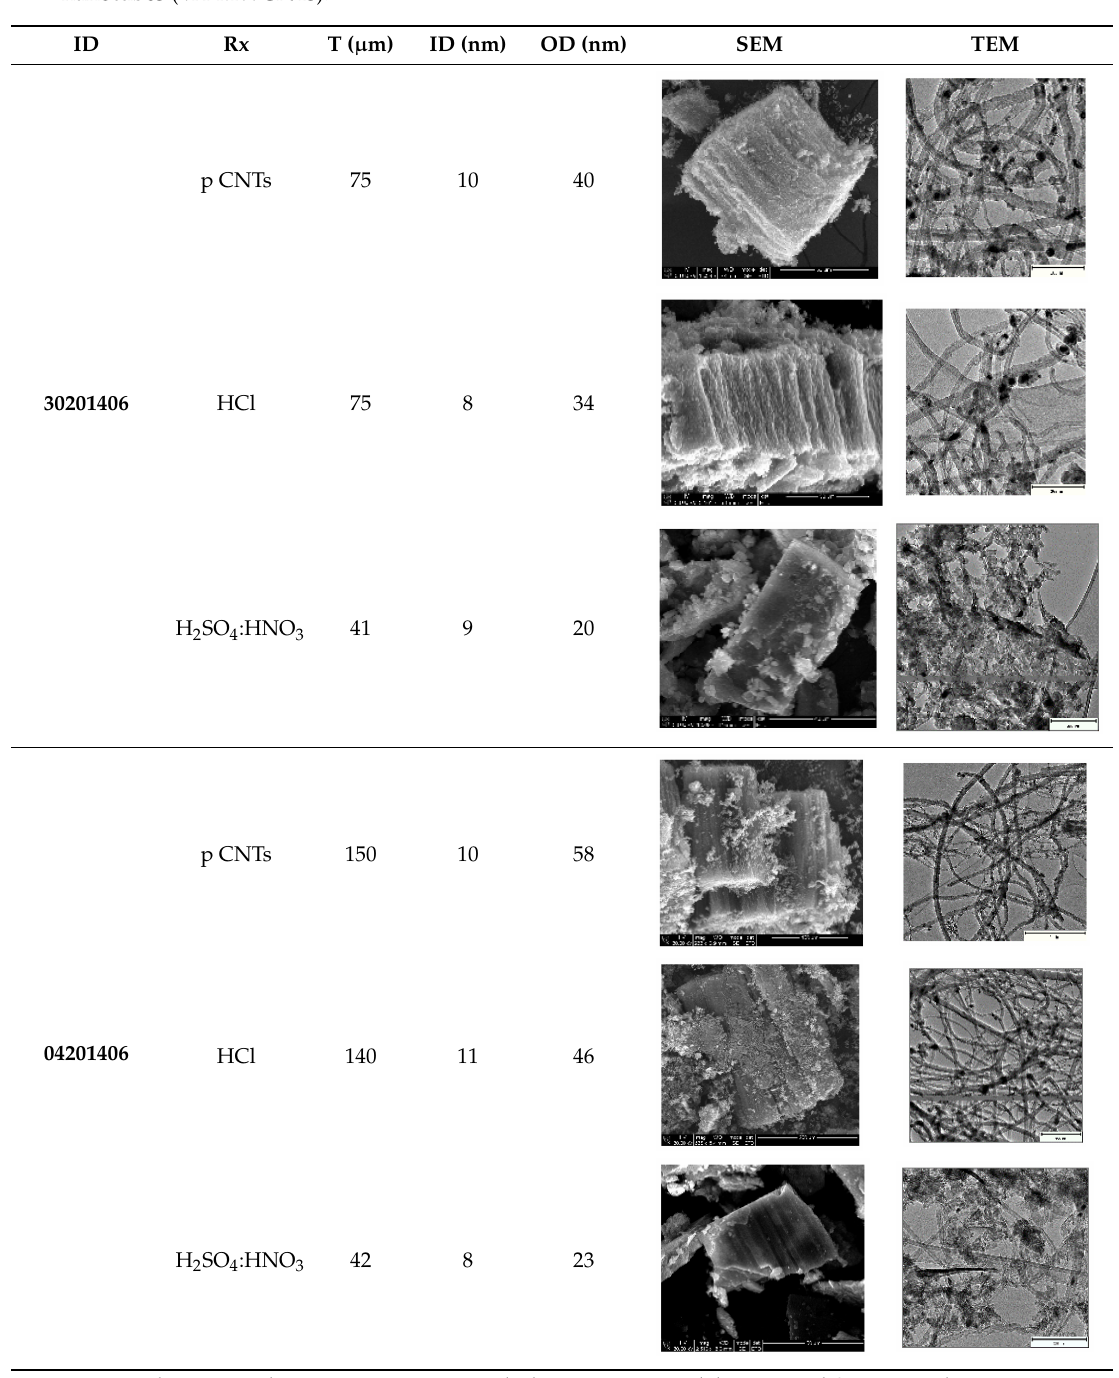
Table 1. Thickness. Internal and external diameters of the vertically aligned-multiwalled carbon nanotubes